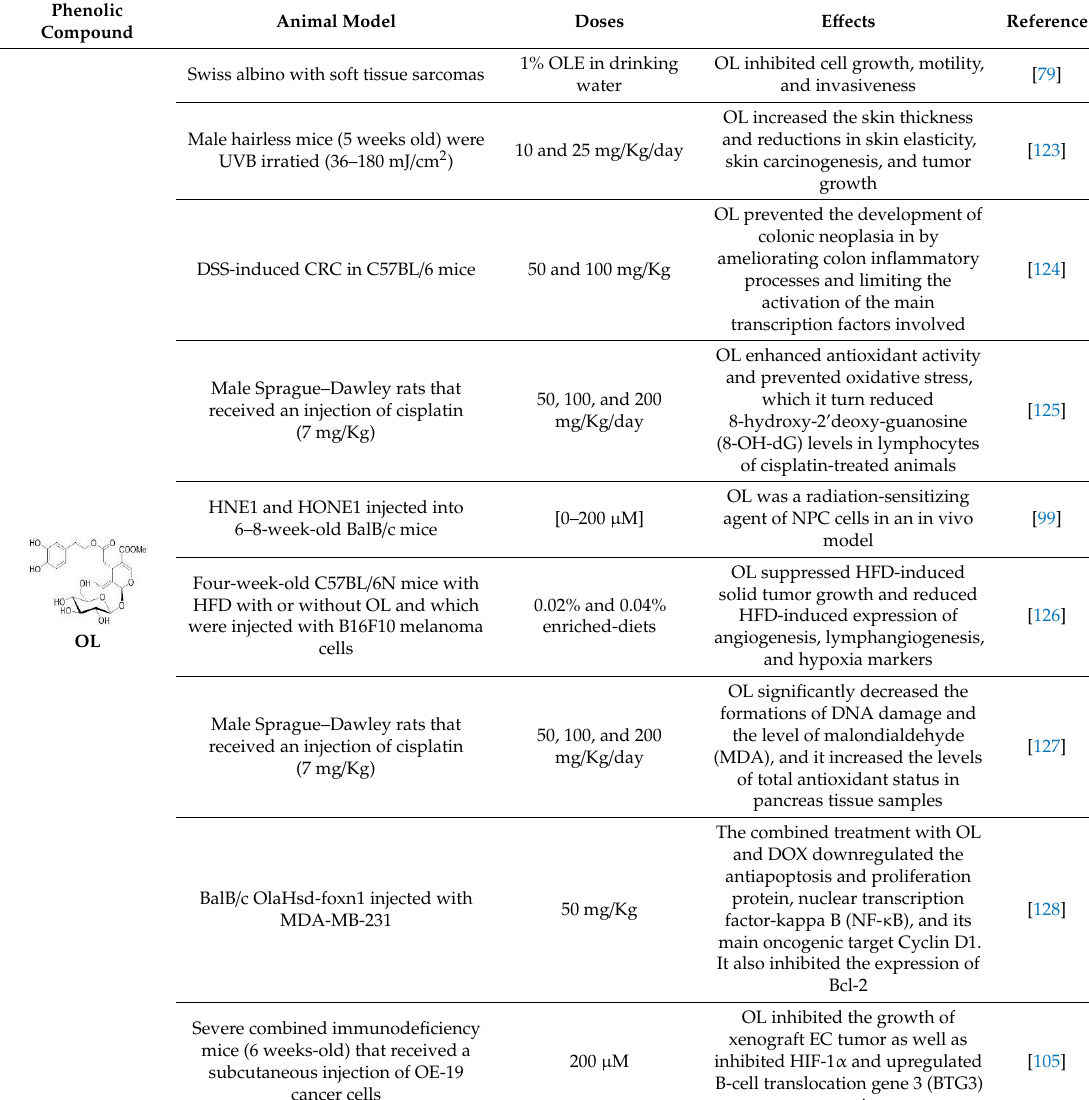
Table 2. Most recent in vivo studies that corroborate the important role of secoiridoids from the olive tree in the control and progression of different types of cancer.